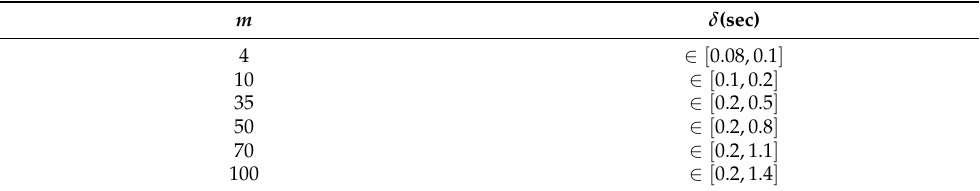
Table 1. Variation results of m and δ .